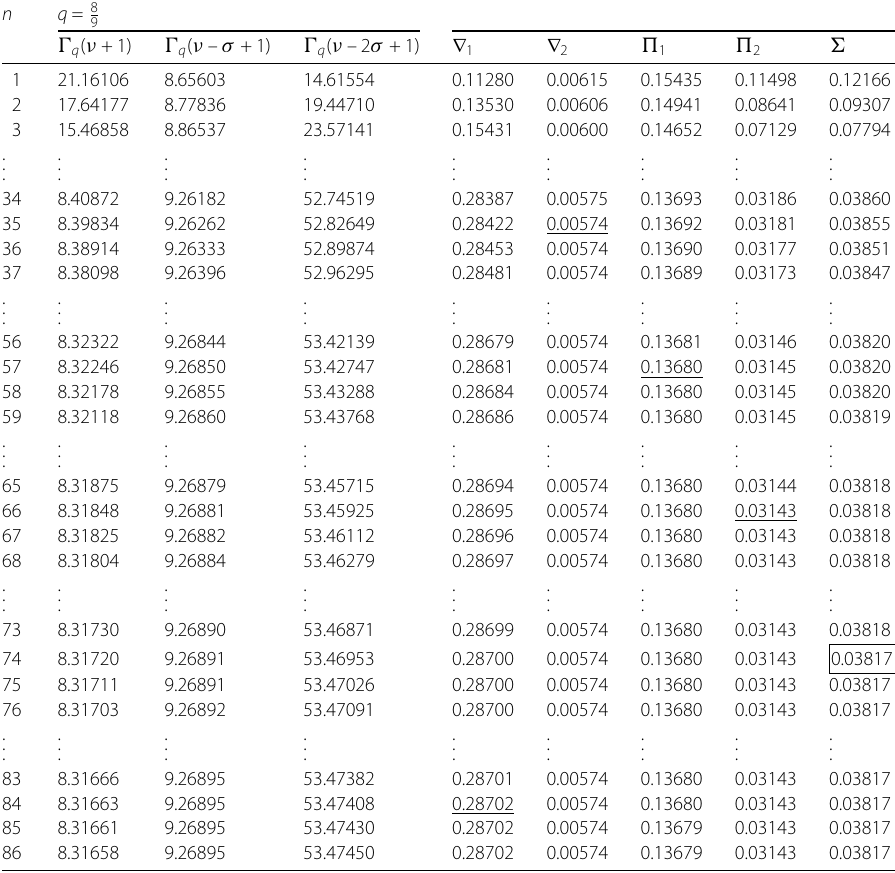
in Example 5.1 9